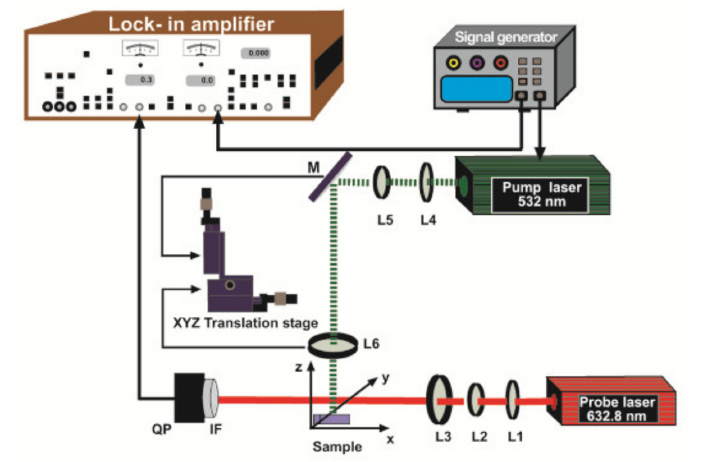
Figure 3. Scheme of the BDS configuration. L1, L2, L3, L4, L5, L6: lenses, M: reflecting mirrors, QP: quadrant photodetector, IF: filter.